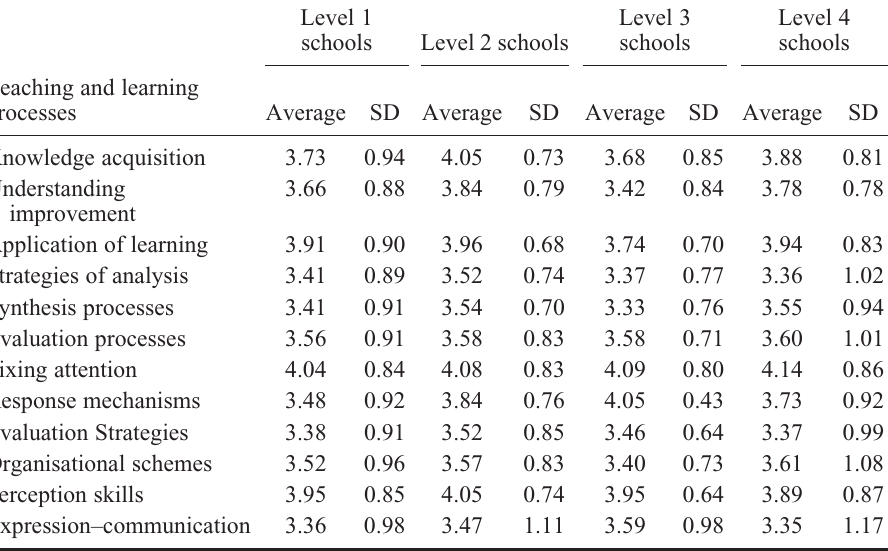
Table 6. Correlation between school levels and the teaching and learning processes